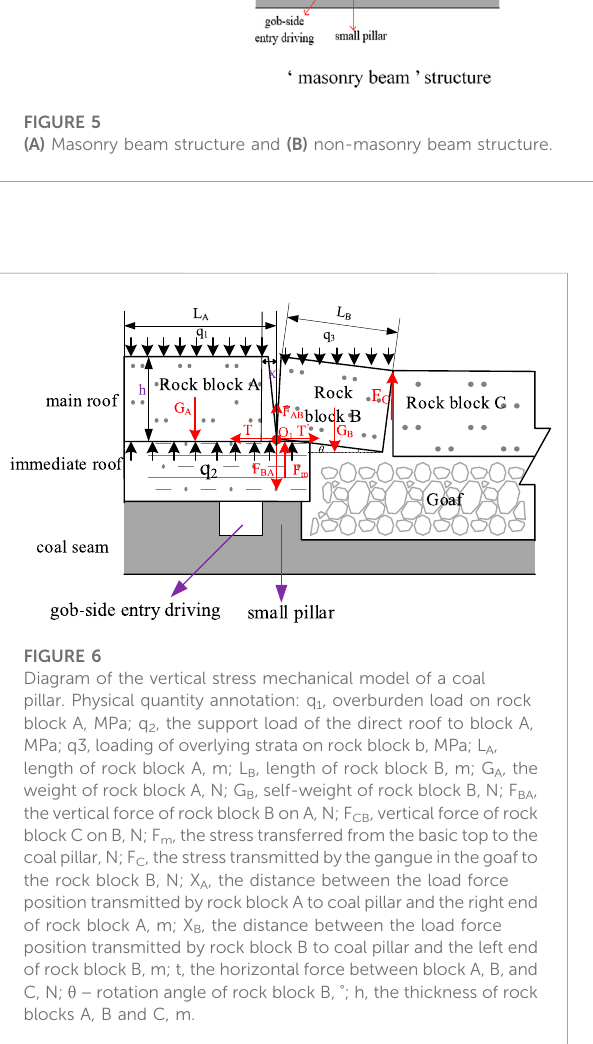
fracture line or the condition of mechanical balance varies, the vertical stress of the coal pillar will also change, as shown in Figure 5. Without human intervention, the migration of the basic roof is a relatively slow process after the breaking trend occurs. The collapse mode of the broken roof (rock block B) is the rotary collapse in Figure 5A, and the masonry structure will inevitably